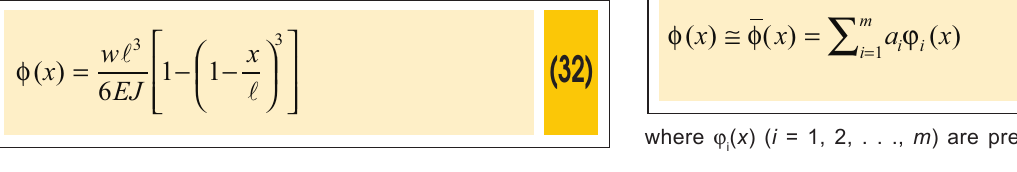
Figure 3 – Continuous model for the bracing